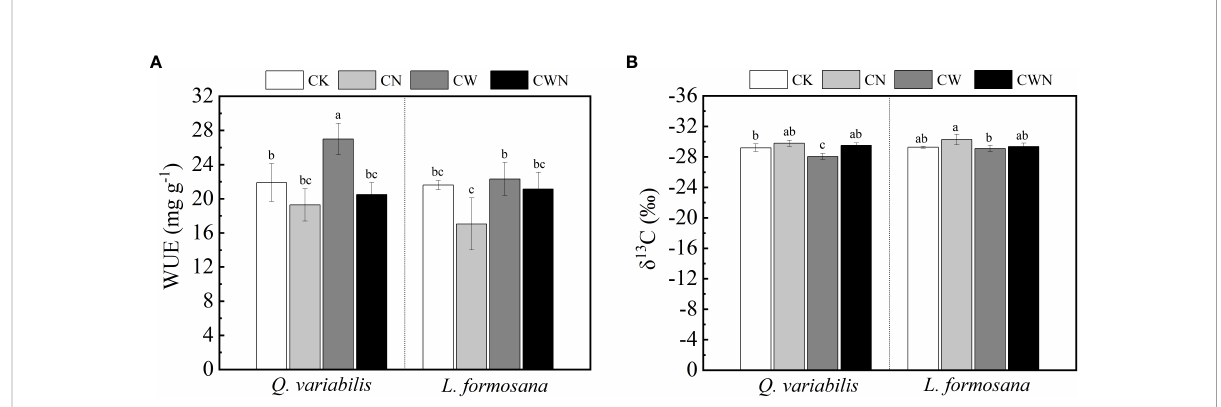
FIGURE 1 Response of long-term water use ef fi ciency (A) and stable isotope carbon (B) of two tree species under canopy N and water additions. Values are means ± SE (n=4). Different letters indicate that the differences in means among the treatments are signi fi cant ( P < 0.05).